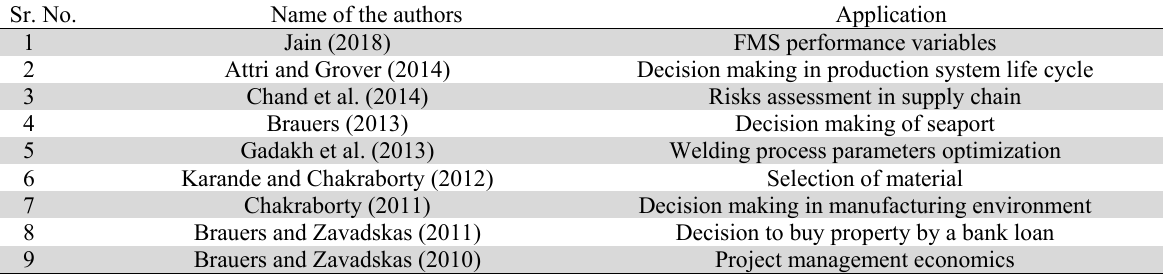
MOORA applications found in literature Sr. No. Name of the authors Application Jain (2018) FMS performance variables Attri and Grover (2014) Decision making in production system life cycle Chand et al. (2014) Risks assessment in supply chain Brauers (2013) Decision making of seaport Gadakh et al. (2013) Welding process parameters optimization Karande and Chakraborty (2012) Selection of material Chakraborty (2011) Decision making in manufacturing environment Brauers and Zavadskas (2011) Decision to buy property by a bank loan Brauers and Zavadskas (2010) Project management